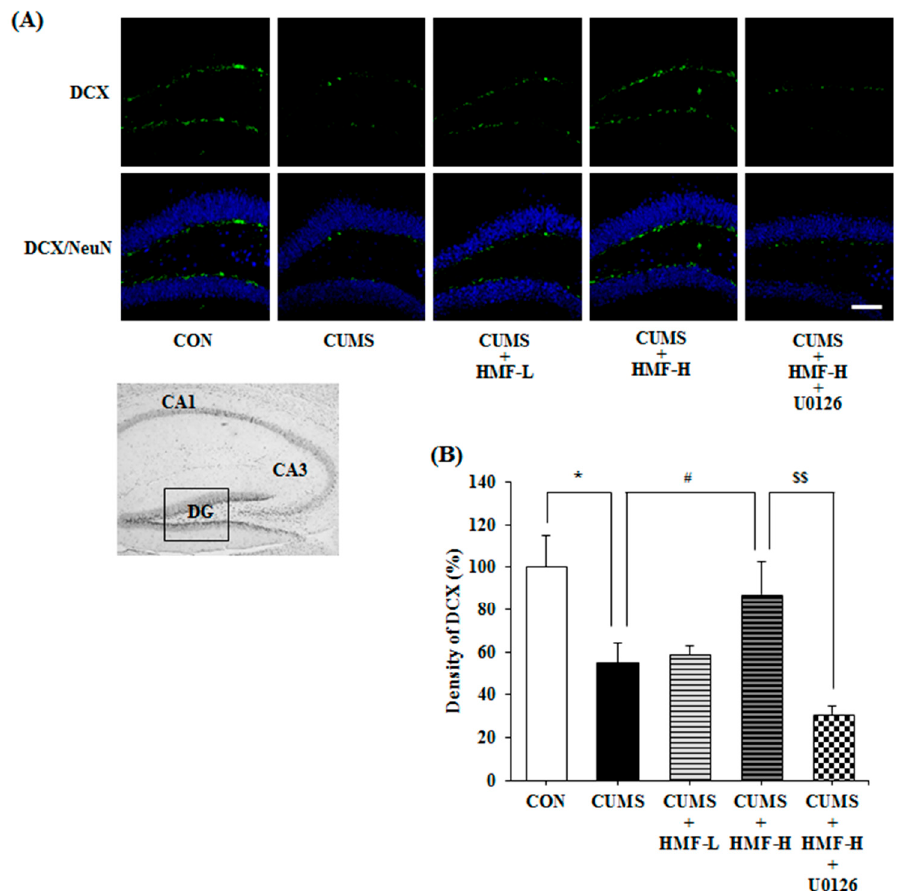
Figure 8. Effects of HMF on neurogenesis in the CUMS-treated mouse hippocampus on Day 16. ( A ) Immunoreactivities of doublecortin (DCX) (green) and neuronal nuclei (NeuN) (blue). The white scale bar shows 100 µ m. The portion for the quantitative analysis was shown with a black square. ( B ) A quantitative analysis of DCX densities. Values are means ± SEM ( n = 6–8). Symbols show significant differences between the following groups: CON vs. CUMS (* p < 0.05, the Student’s t -test), CUMS vs. CUMS + HMF-H ( # p < 0.05, one-way ANOVA followed by the post-hoc Williams multiple comparison test) and CUMS + HMF-H vs. CUMS + HMF-H + U0126 ( $$ p < 0.01, the Student’s t -test).